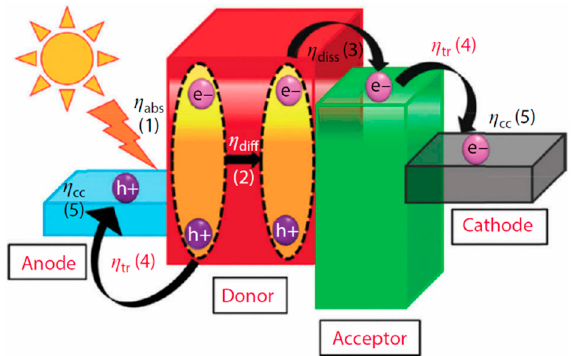
Figure 1. The overall energy arrangement of the conjugated polymer and QD BHJ solar cell, with indication of charge transport and efficiency at each part of the cell. Reproduced with permission from [4]. Copyright 2015 Wiley and Sons.